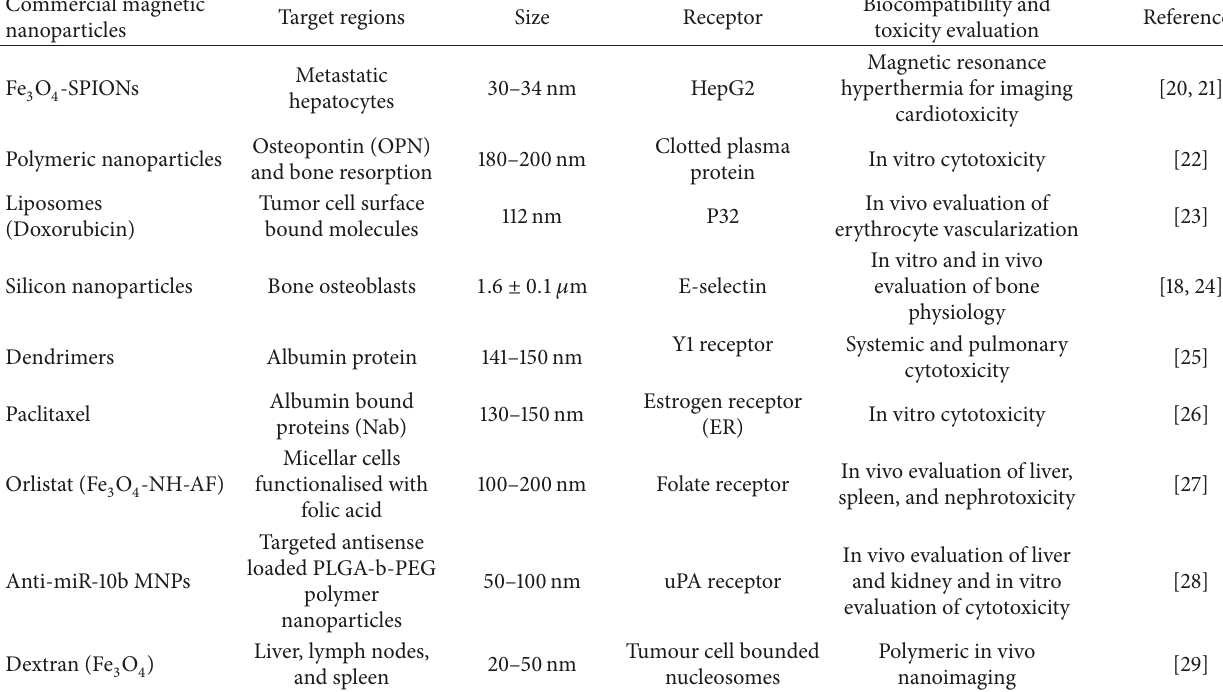
Table 1: Summary of the commercially available nanosystems as contrast agents for preclinical and clinical